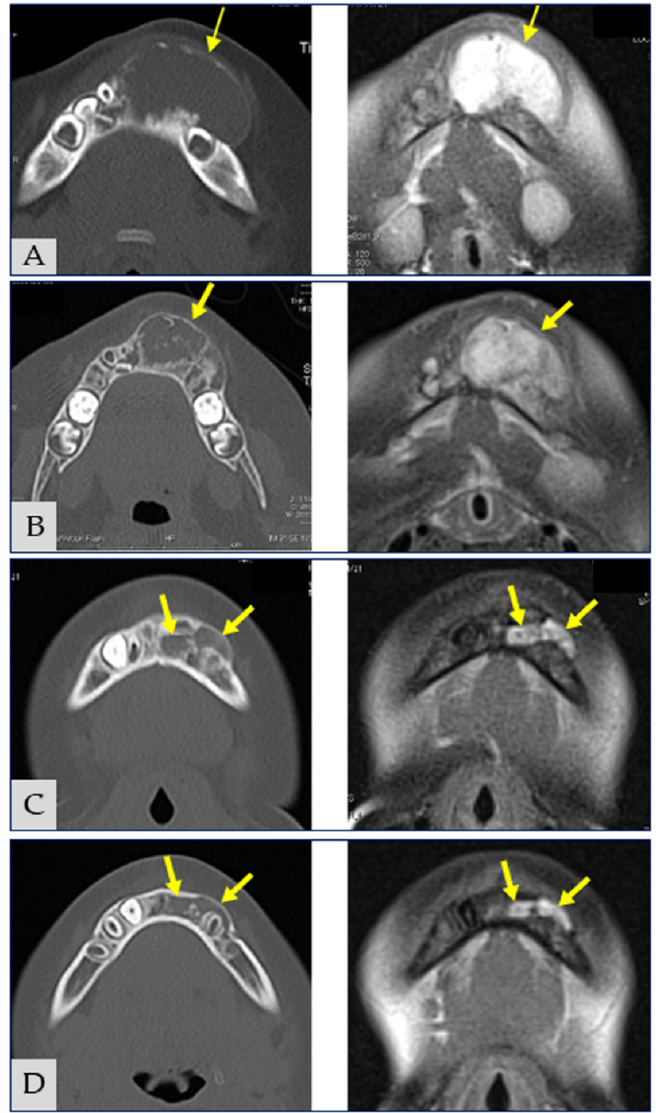
Figure 8. Sequential radiographic changes for MNTI by CT on the left side and MRI on the right side. ( A ) Before the start of treatment at the age of 8 months; ( B ) 1 month later, after the biopsy; ( C ) 4 years and 6 months later, after the biopsy; ( D ) 6 years and 6 months later, after the